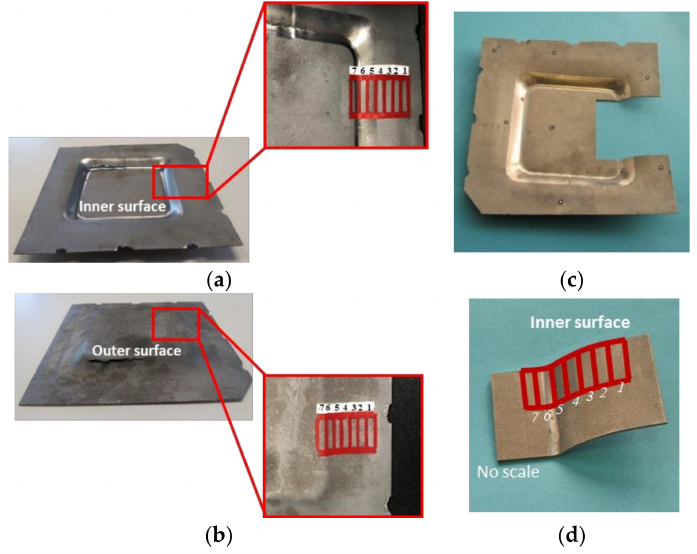
Figure 2. Scanned surface area to determine the residual stress values on ( a ) the inner surface, ( b ) the outer surface, ( c ) cut SPIFed formed part, and ( d ) sample piece used to measure residual